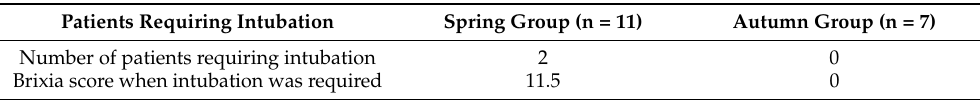
Table 4. Patients who required intubation in the two groups, and Brixia score (mean value) when intubation was required.